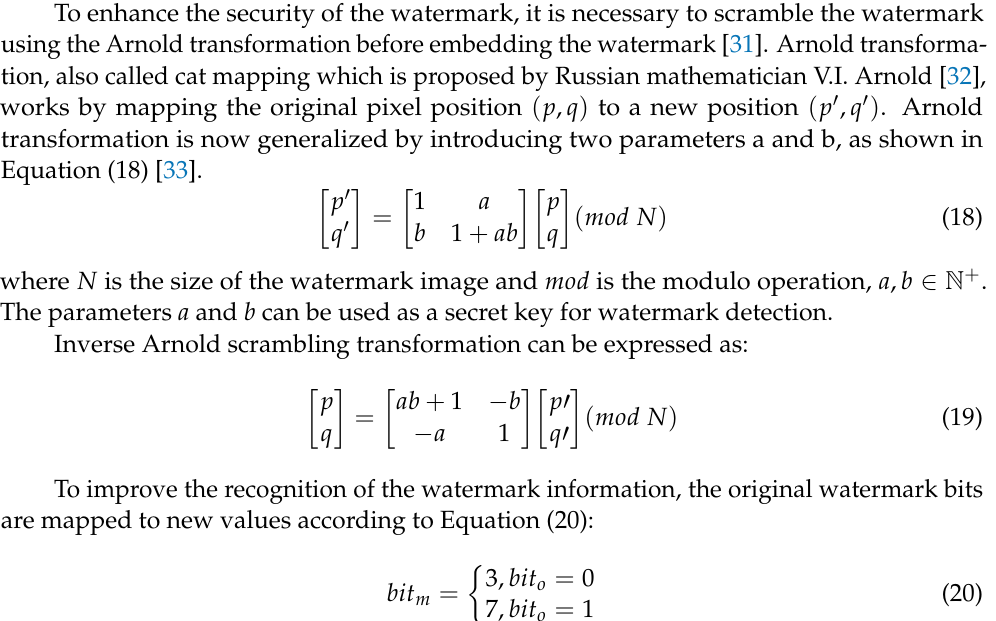
Figure 1. Sample of watermark image. ( a ) Watermark image; ( b ) watermark index; ( c ) watermark bit.